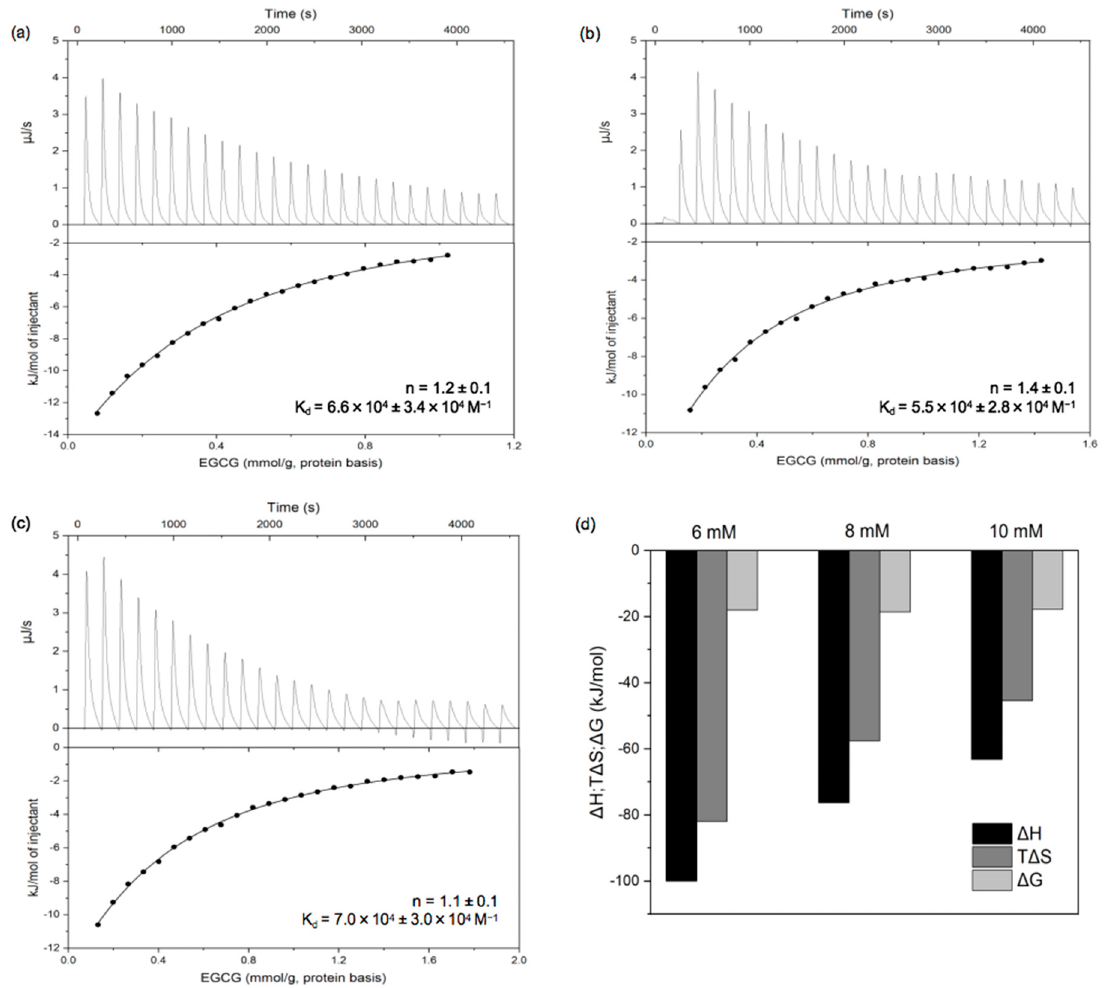
Figure 5. Thermograms ( top ) and binding isotherms ( bottom ) for titration of 6 mM ( a ), 8 mM ( b ), and 10 mM ( c ) EGCG into PPI dispersion (1 mg/mL) and thermodynamic profile of EGCG and PPI interaction ( d ).